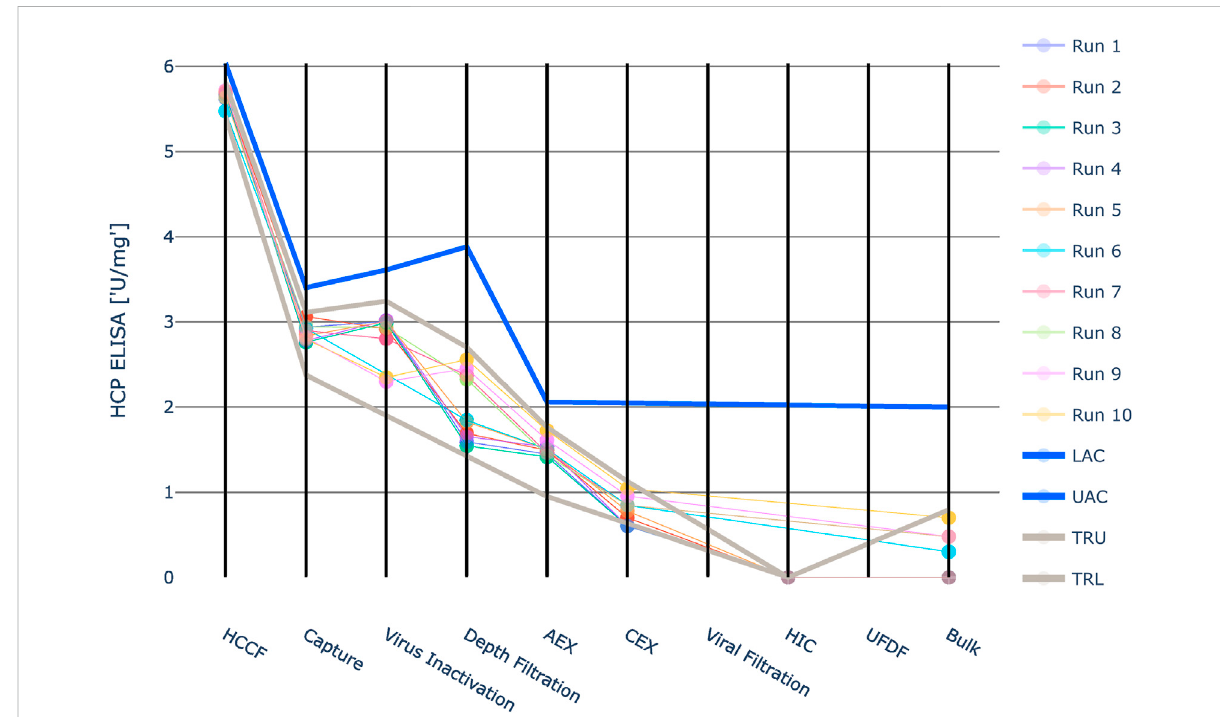
FIGURE 9 Graphical representation of the intermediate acceptance criteria (blue line) across the entire downstream process for the response HCP ELISA. Available large scale, manufacturing data per batch (circles) and three standard deviation ranges (grey lines) are given as well. The shown iACs at DS aretheDSspeci fi cationlimits.DuetothelargevaluerangeofthisHCPELISAthevalueswerelogarithmicallyscaledforvisualizationpurposes.Except forunitoperation7 atthelast fi veunitoperationstheintermediateacceptancecriteriaweresetequaltothedrugsubstancespeci fi cationlimits. At unit operation 7 CQA measurements are available, however they all represent one value: the limit of quanti fi cation. For that reason no standard deviation could be calculated and integrated process modeling could not be